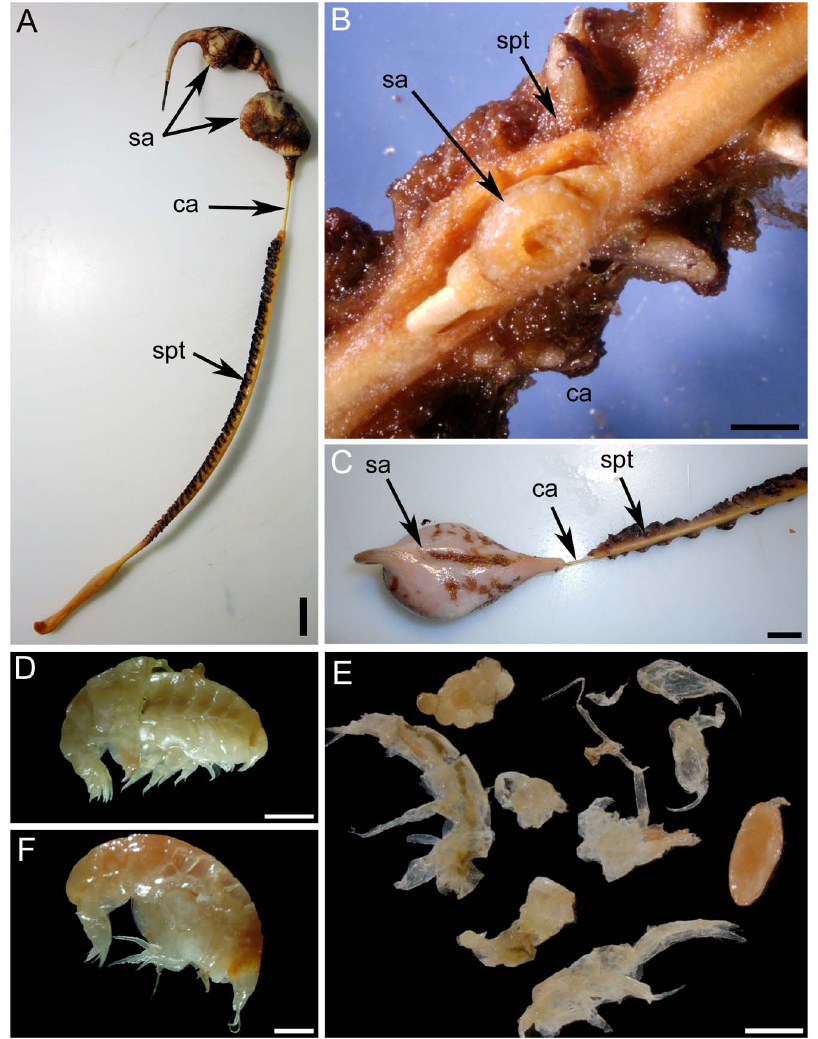
Figure 4. The sea anemone Stephanaugenexilis using the central axis of Halipterisfinmarchica as a substrate: (A) general view of a colony of H.finmarchica harbouring two sea anemones in the upper section, (B) a small sea anemone surrounded by sea pen tissues, (C) dorsal view of the sea anemone found on the upper section of the sea pen colony. Gastro-vascular contents were found: (D and F) amphipod, (E) mix of prey including amphipods, halocyprids, egg mass, and unidentified food item extracted from one sea anemone. sa: sea anemone, ca: central axis, spt: sea pen soft tissues. Scale bar in A=2 cm, in B and D=2 mm and C and F=1 cm, E=1 mm.